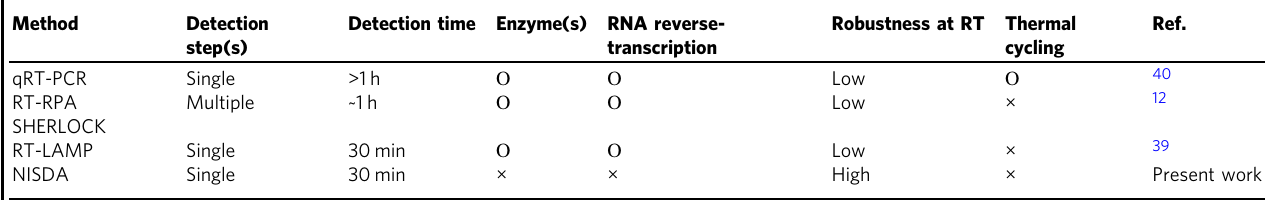
Table 2 Comparison between NISDA assay and similar molecular diagnostic methods.